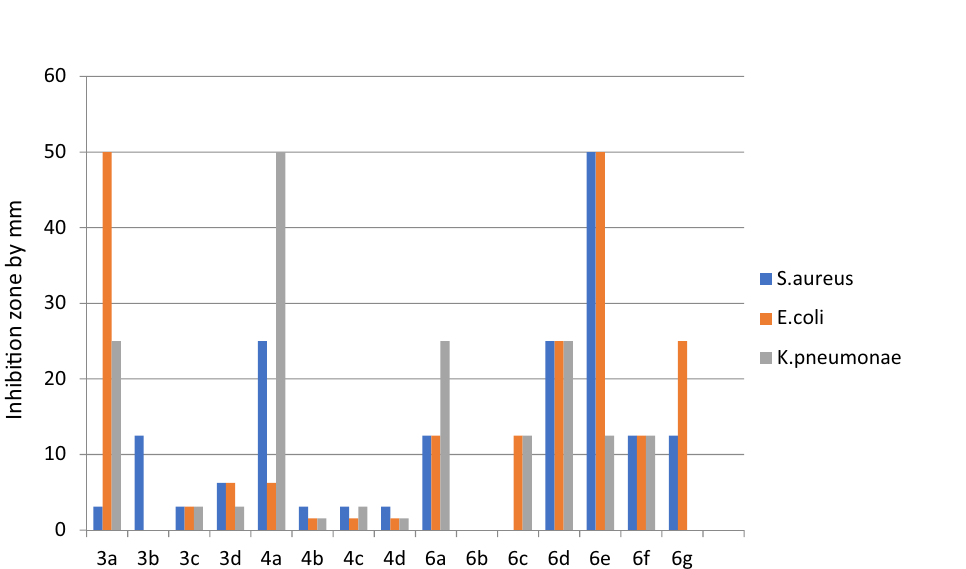
Figure 5. Sensitivity test of the synthesized compounds against three clinical isolates. Inhibition zones are expressed in